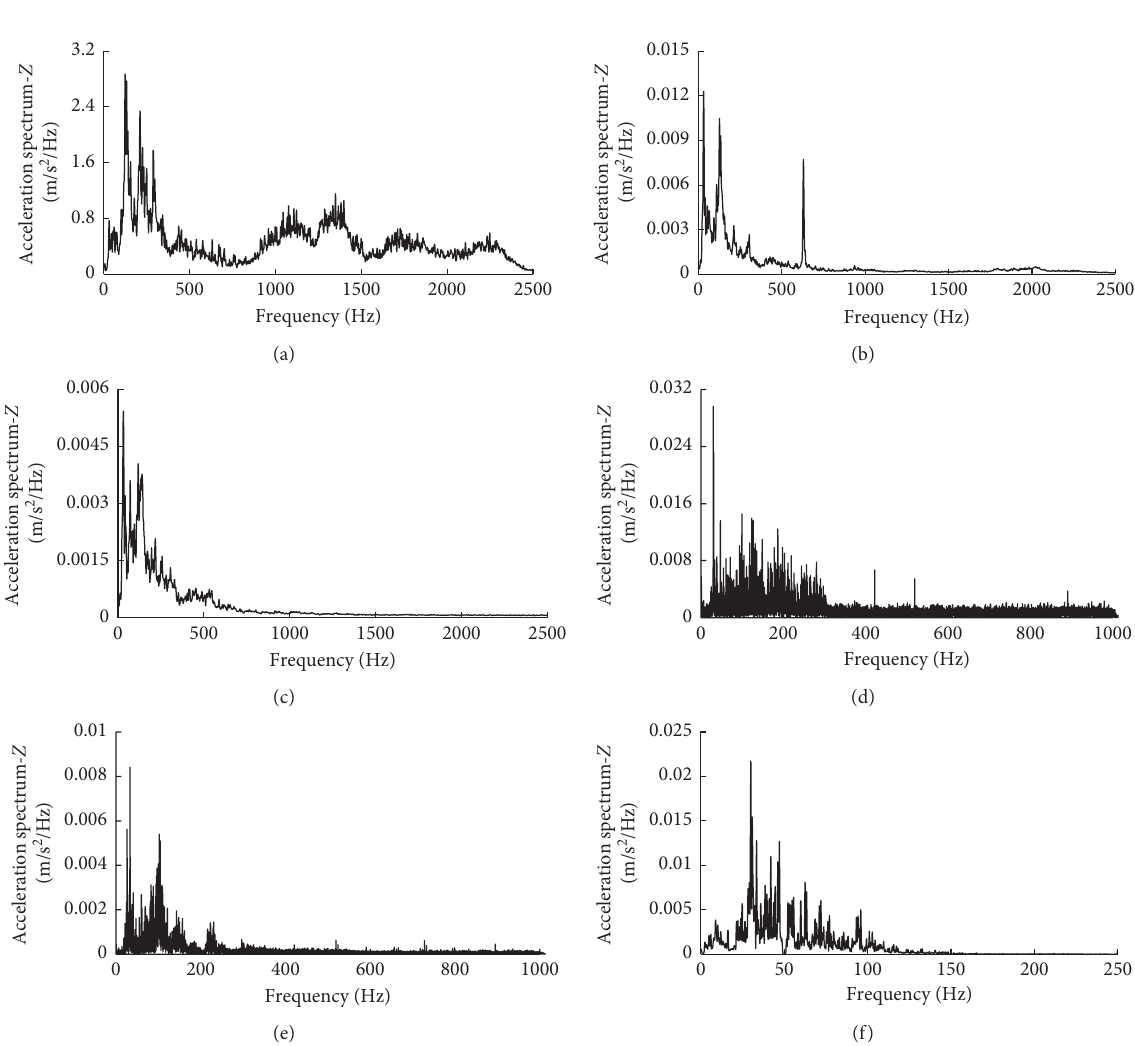
Figure 19: Frequency spectrum curves of the vertical acceleration: (a) rail foot; (b) track bed; (c) tunnel wall; (d) A024; (e) 1#; (f)